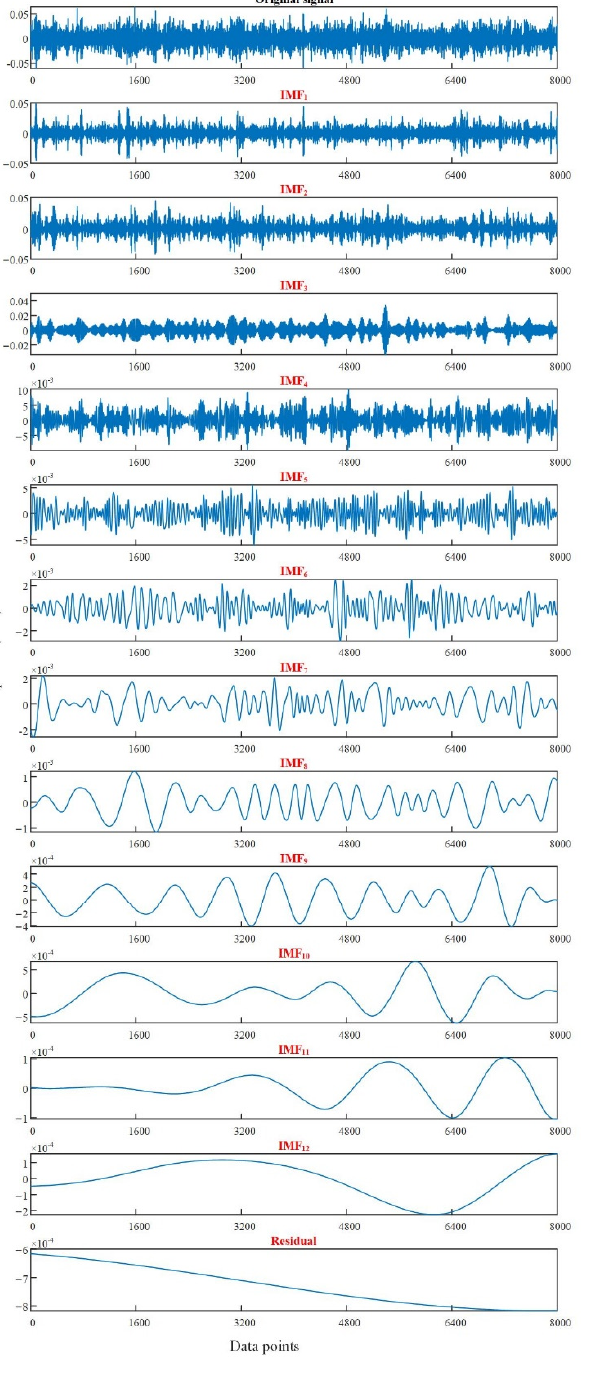
Figure 17. EMD result of normal bearing vibration signal.